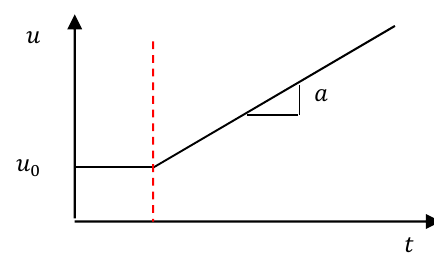
Figure 3. Inflow boundary condition.